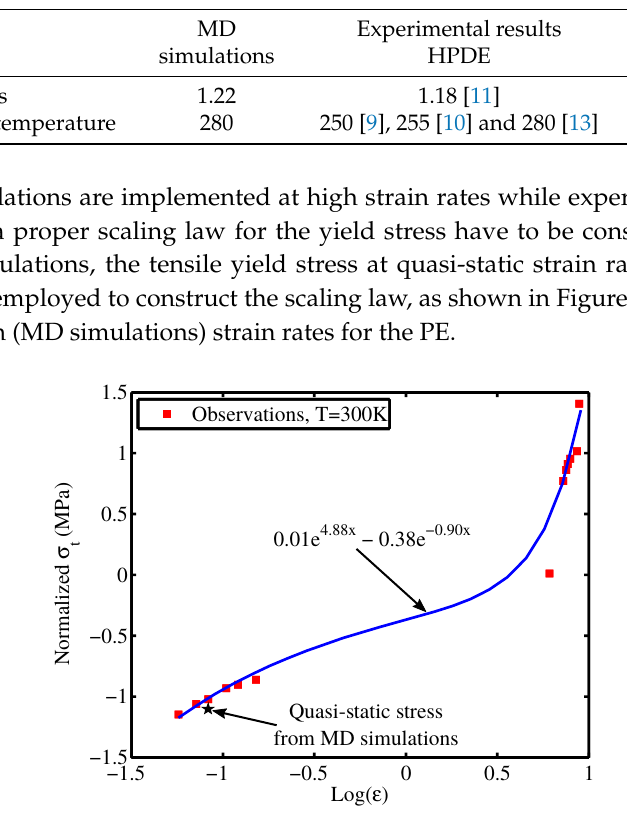
Figure 6. The extended constitutive law for the PE for the strain rate ranging from low (experiments) to high (MD simulations) values. The red solid squares represent the obtained tensile yield stresses from MD simulations (the group of values on the right) and experiments (the group of values on the left). The blue solid line is the fitted curve constructed based on the Bayesian method, see Section 4.2 in the manuscript. The black solid star represents the tensile yield stress under quasi-static